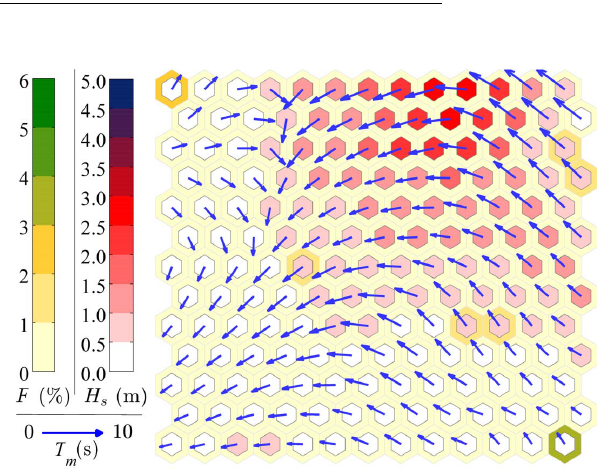
Figure 7. MDA-SOM output map, 80% reduction of the original data set. H s : inner hexagons’ color, T m : vectors’ length, θ m : vec- tors’ direction, F : outer hexagons’ color. Mean quantization error: 0.06; topographic error: 15%.